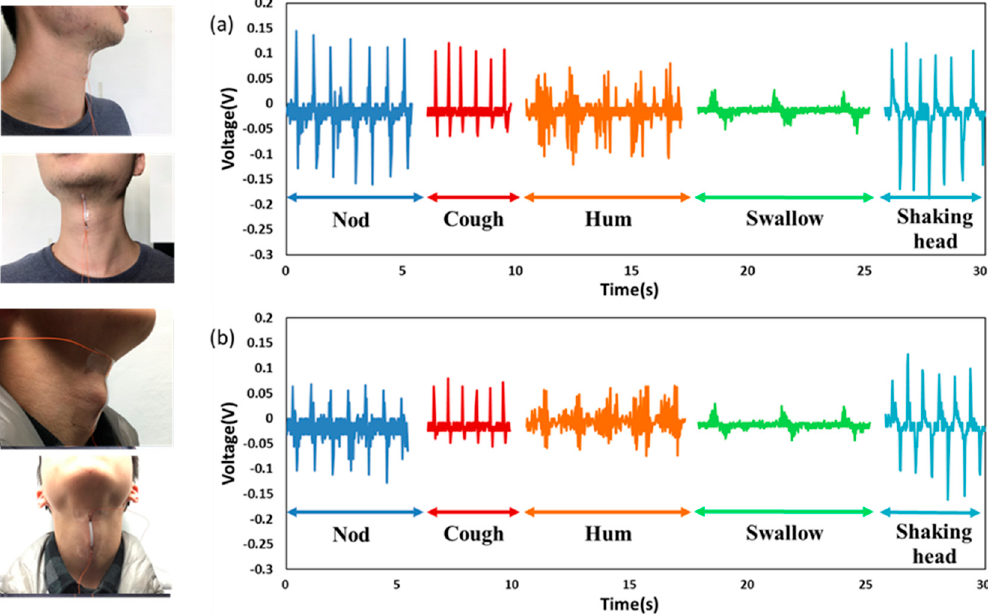
Figure 4. Responses towards different kinds of throat vibrations. ( a ) The ISSE’s output voltage with various throat movements (nod, coughs, hums, swallow and shaking head) of the test subject (A). ( b ) Same test as performed by subject (B).